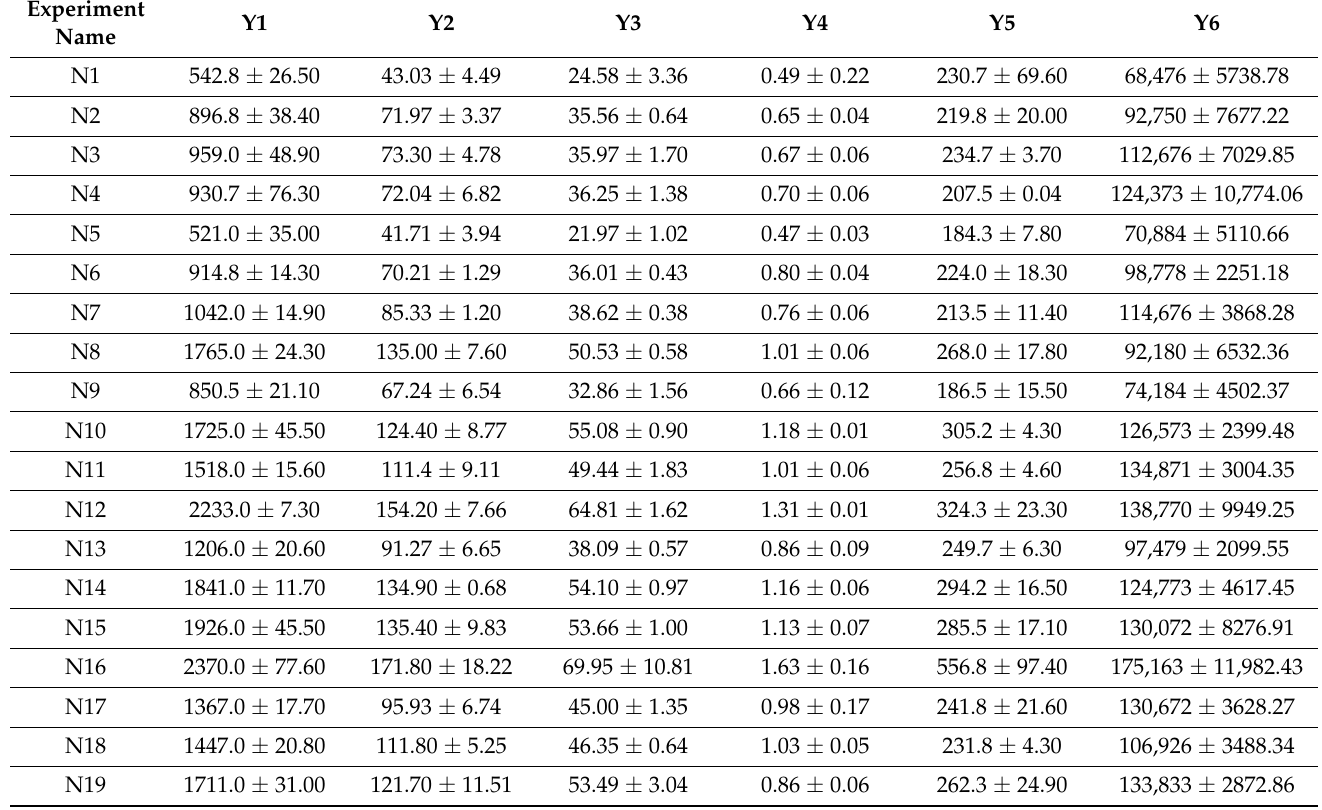
Table 4. The results of selected output